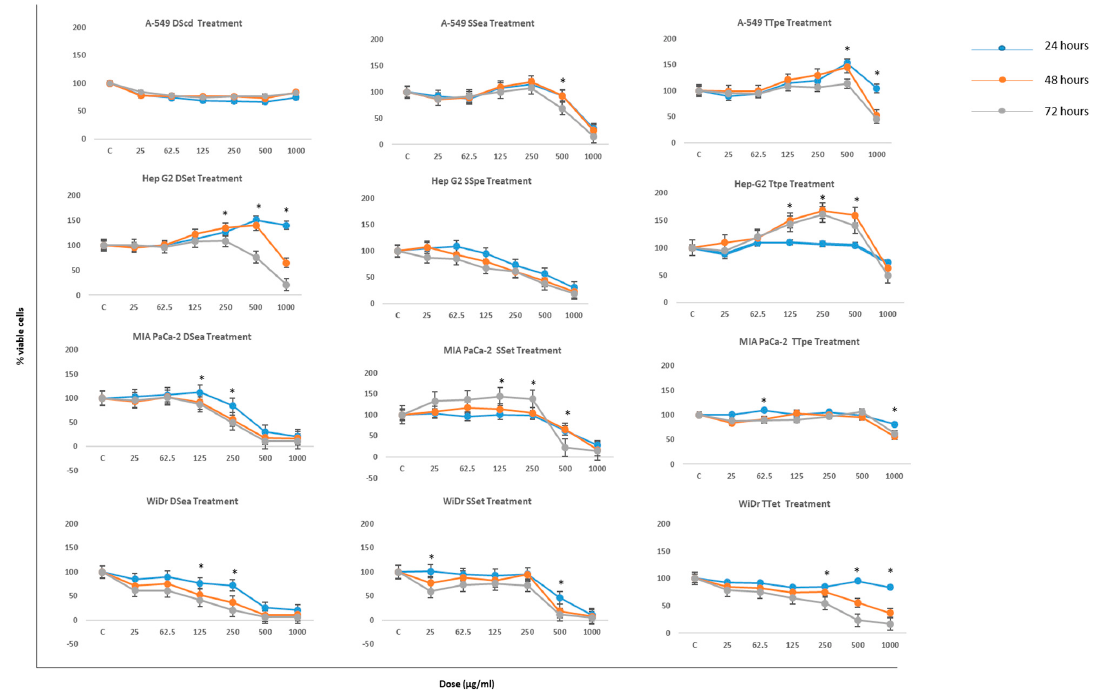
Figure 1. The inhibitory effect of New Zealand (NZ) surf clam extracts on the growth of A-549, Hep G2, MIA PaCa-2, and WiDr after an incubation time of 24, 48, and 72 h. Cells were incubated in the presence of various extract concentrations. A relative cell viability of 100% was designated as the total number of cells that grew after each time point. Each experiment was carried out twice, in triplicate. Data is presented as means ± SE. * indicates statistical significance, p < 0.05.